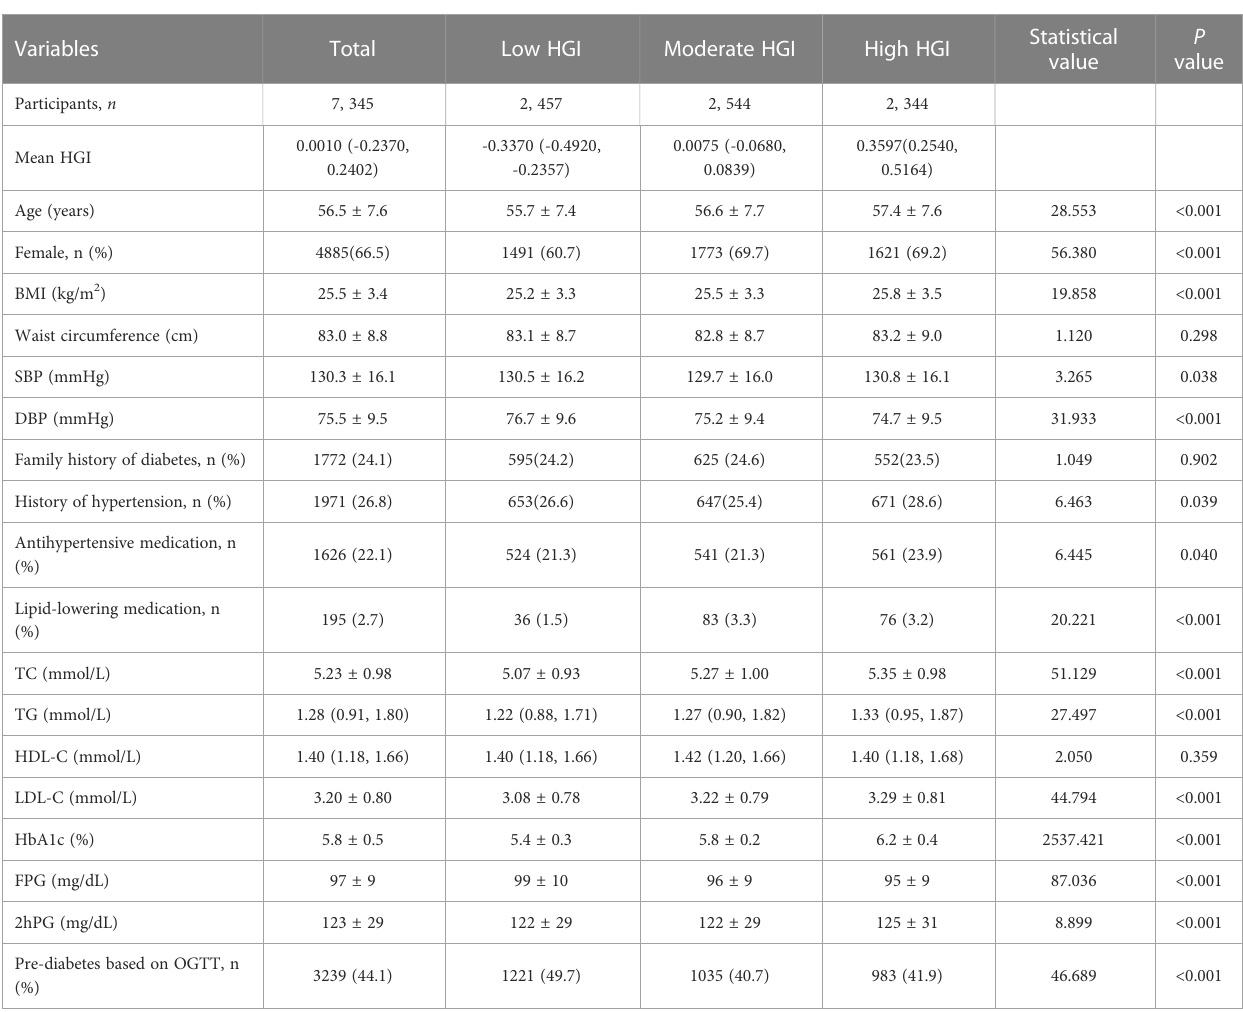
TABLE 1 Baseline characteristics of 7,345 participants in 2011.